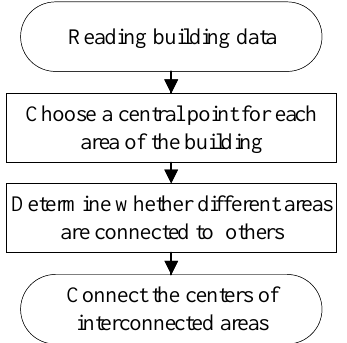
Figure 3. Cabin model networking